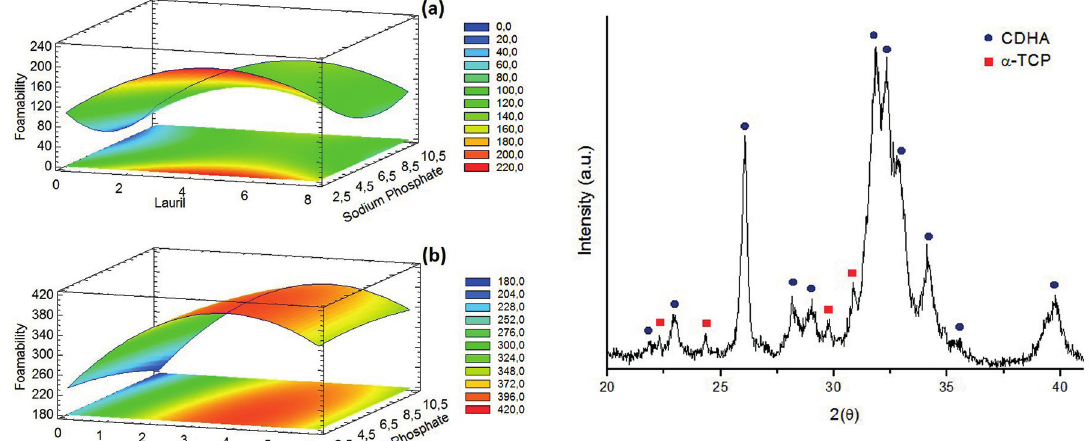
HPO and (a) SLS and (b) L110. 2 4 HPO concentration was also 2 4